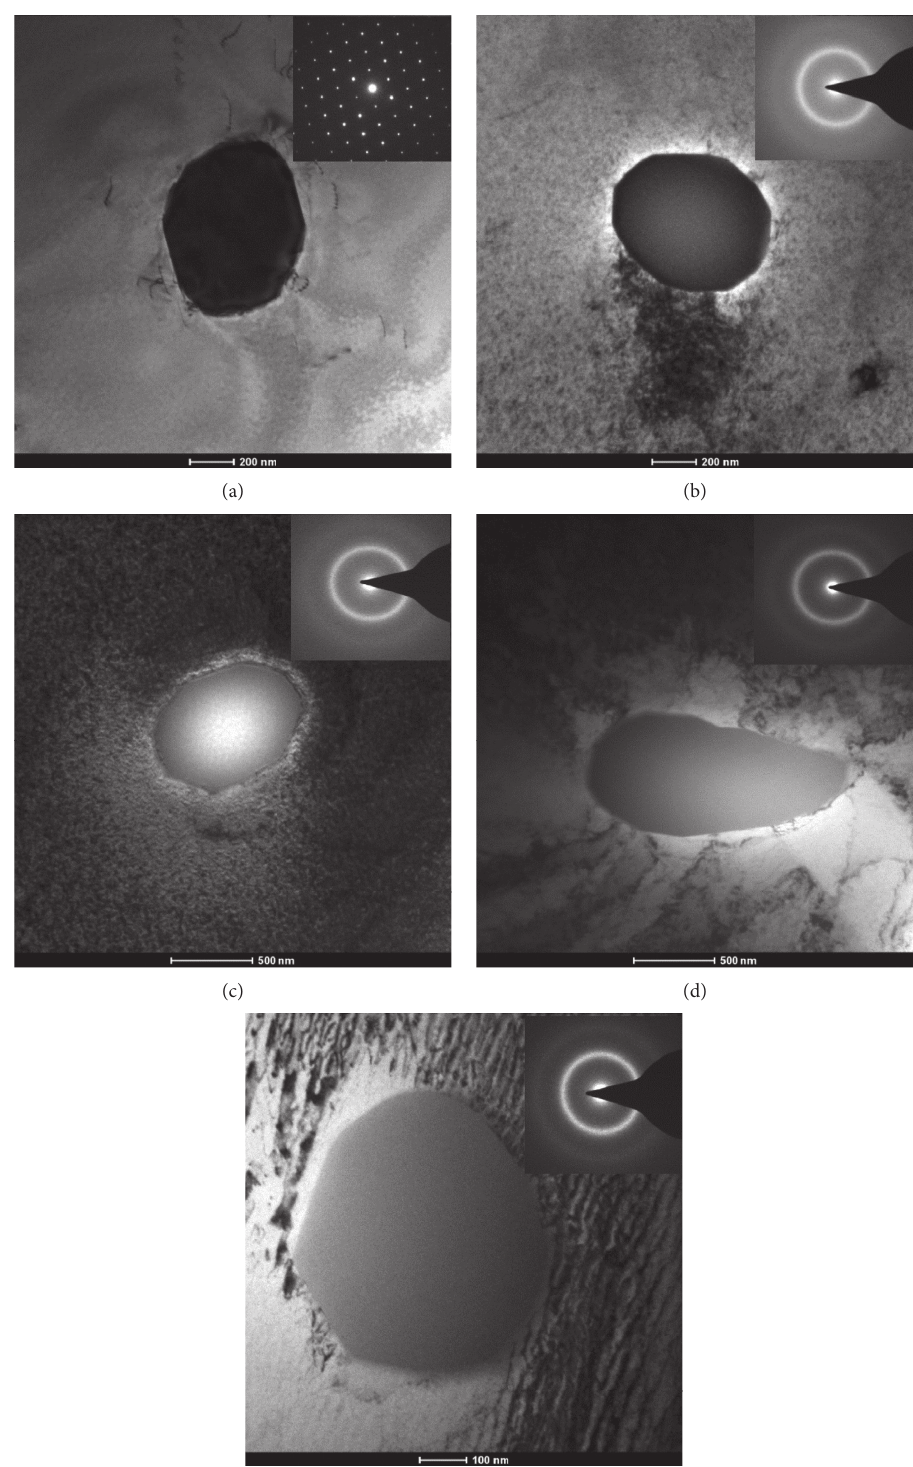
Figure 4: Phases in Hastelloy N alloy before and after ion irradiation: (a) 0dPa, (b) 0.5 dPa, (c) 2 dPa, (d) 5dPa, and (e)